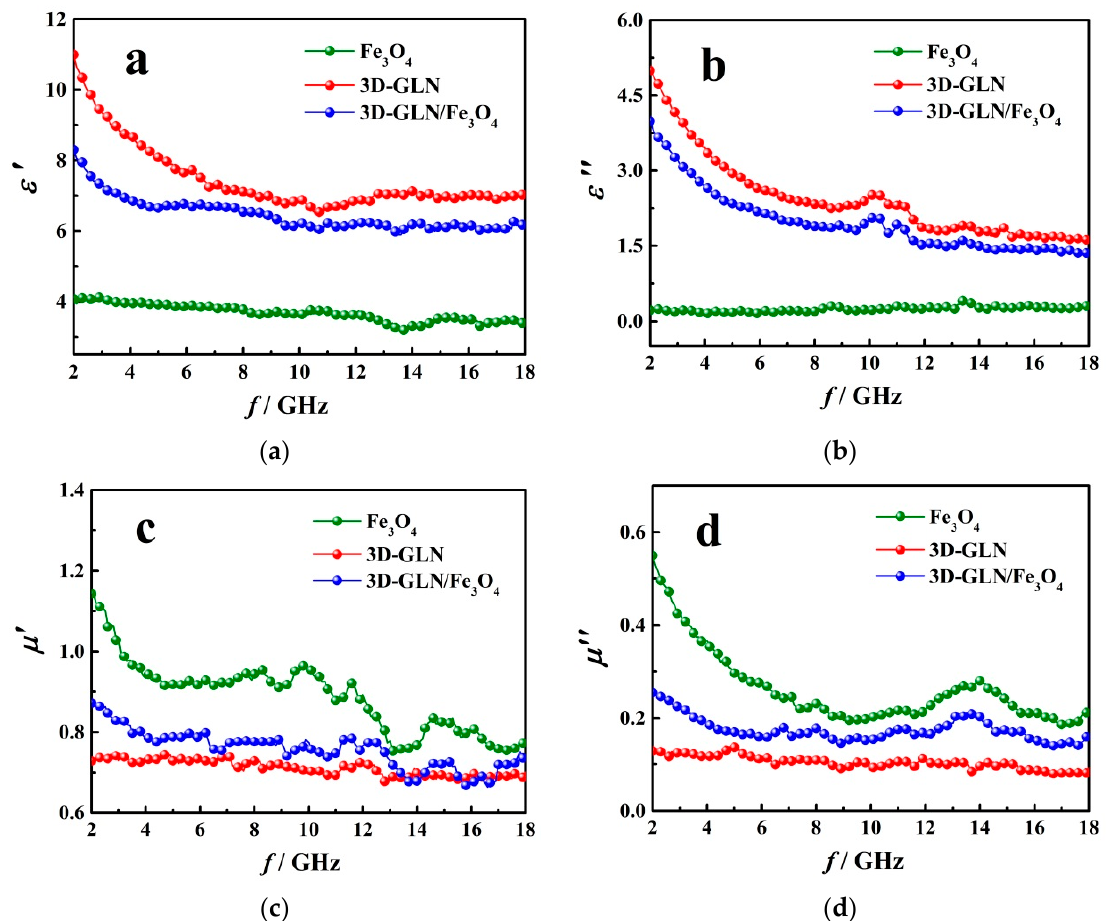
Figure 8. Frequency dependence of ε ′ and ε ′′ ( a , b ) and μ ′ and μ ′′ ( c , d ) for Fe 3 O 4 , 3D-GLN and 3D-GLN/Fe 3 O 4 .